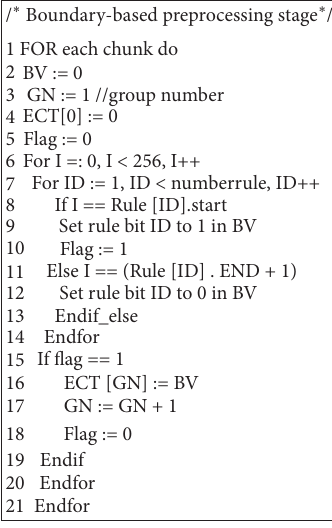
Figure 5: Boundary-based preprocessing